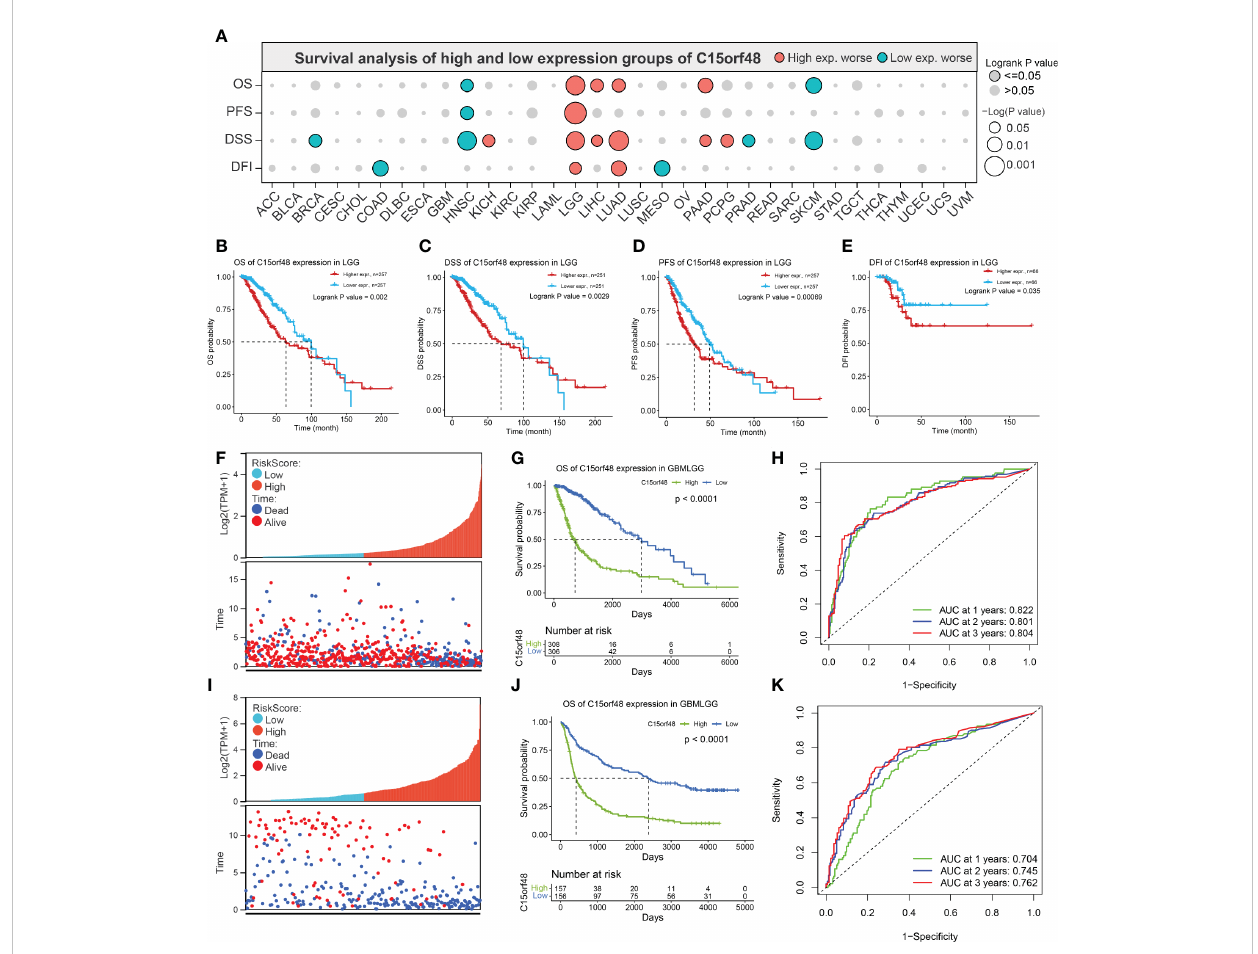
FIGURE 2 (A) Prognosis of C15orf48 in pan-cancer; (B-E) High expression of C15orf48 was signi fi cantly correlated with shorter OS, DSS, PFS, and DFI of LGG; (F-H) Relationship between C15orf48 expression and glioma prognosis score, survival analysis and ROC analysis (TCGA-GBMLGG datasets); (I – K) Relationship between C15orf48 expression and glioma prognosis score, survival analysis and ROC analysis (CGGA325